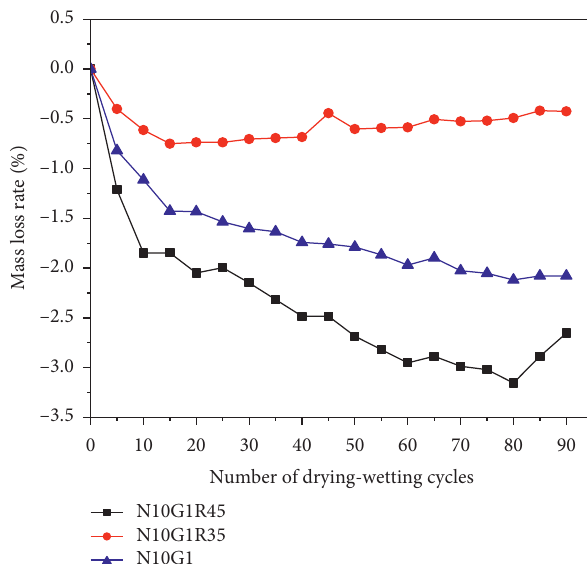
Figure 2: Variation of the mass loss rate of concrete with different water-binder ratios.